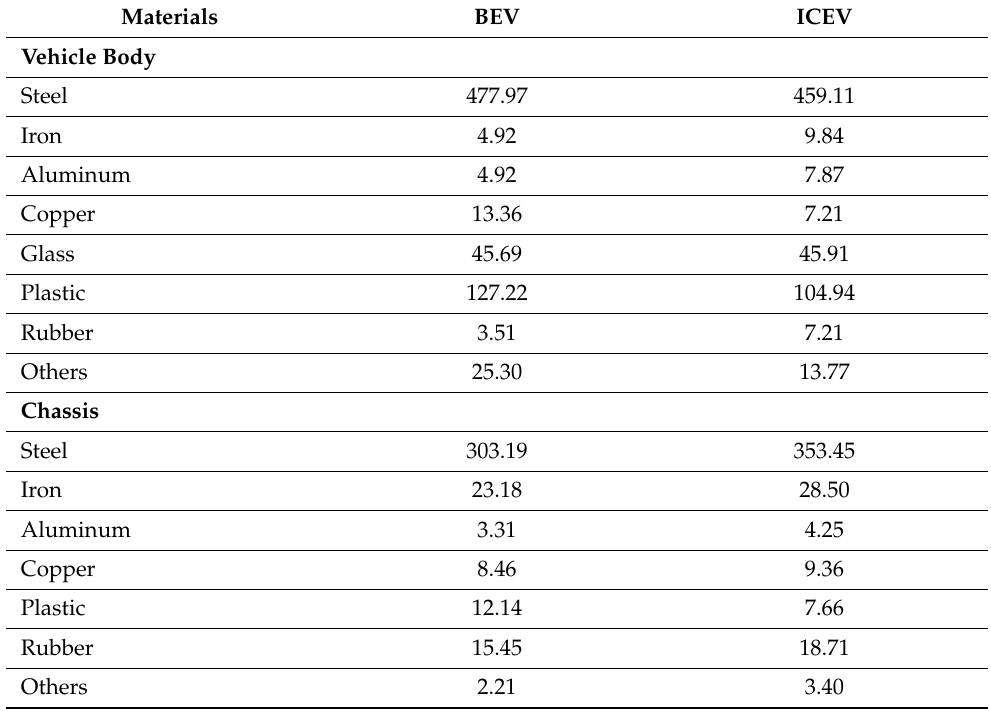
Table A1. Materials inventory of the vehicles (unit: